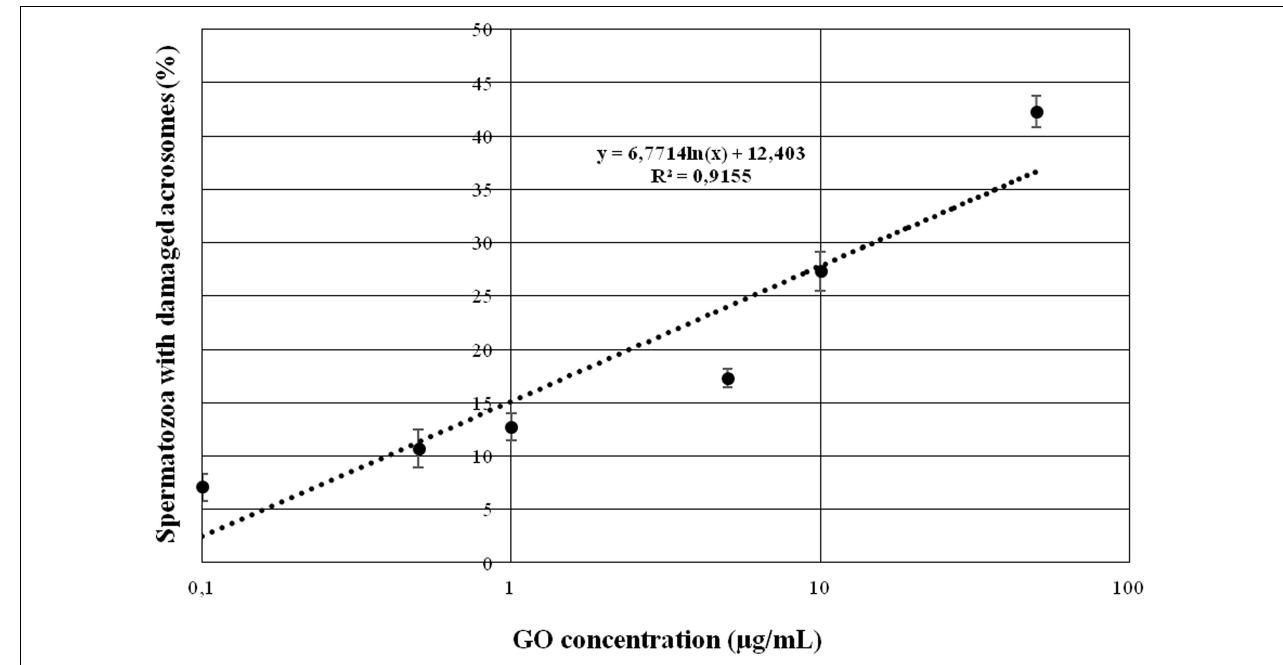
FIGURE 1 | Graph showing the effects of increasing GO concentrations on sperm acrosome integrity when incubating under capacitating